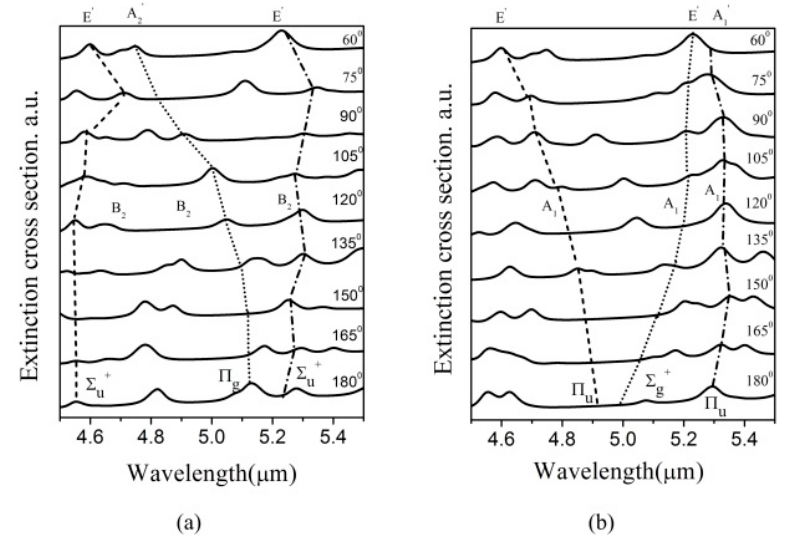
Figure 6. Scattering extinction cross-section as a function of wavelength ranging from 4.5 to 5.5 μ m. ( a ) The incident light is longitudinally polarized, ( b ) the incident light is vertically polarized.